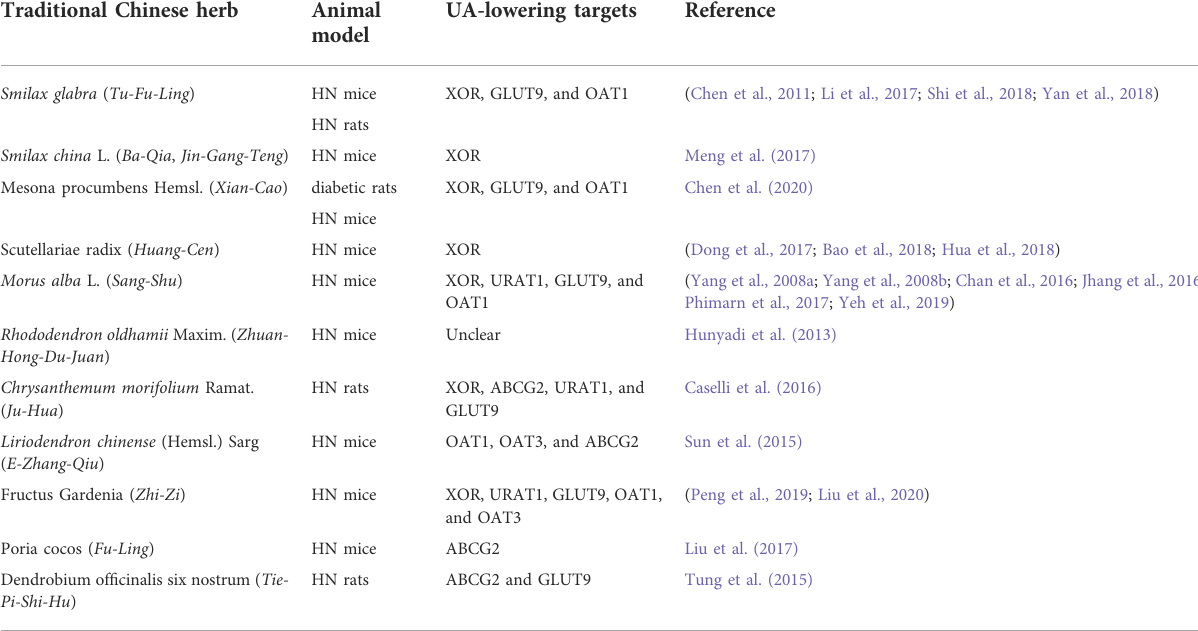
TABLE 1 Uric acid – lowering effects of traditional Chinese